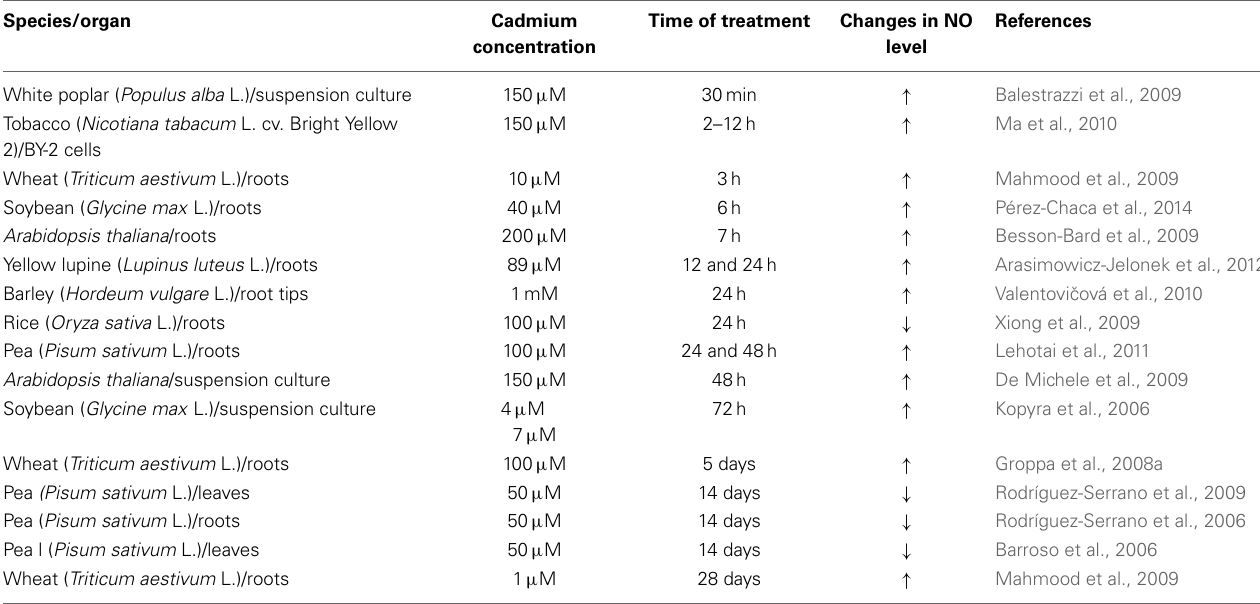
Table 2 | The effects of various Cd doses on NO generation in